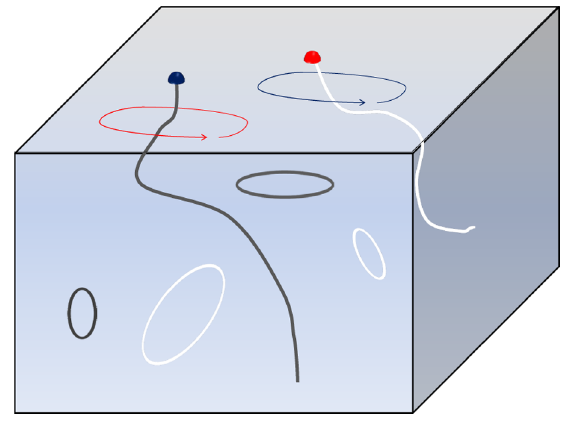
FIG. 1. Schematic depiction of a 3D symmetry-protected topological phase, with two conserved species of bosons [ U ð 1 Þ (cid:1) U ð 1 Þ , blue and red] and time-reversal symmetry ( Z T The bulk is insulating and corresponds to a condensate of vortices of both species (shown as black and white loops). In the topological phase, the vortex line of one species that ends on a surface carries half charge of the other species. Such a surface, it may be argued, does not have a trivial gapped phase, where the symmetries are preserved. Pictorially, the vortex lines may be viewed in 1D Haldane phases, with half-charged end